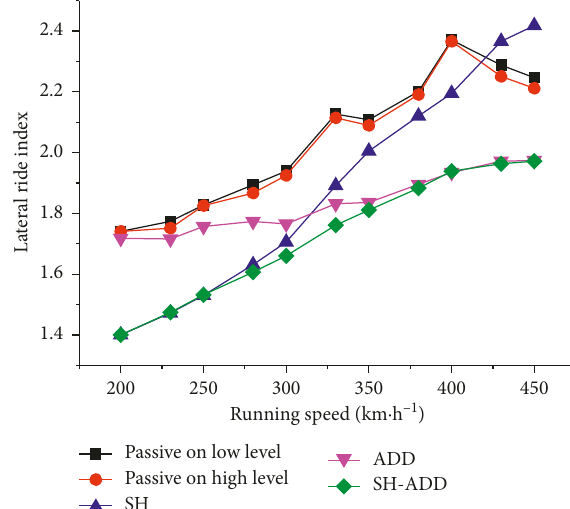
Figure 19: Influence of semiactive control on the lateral stability